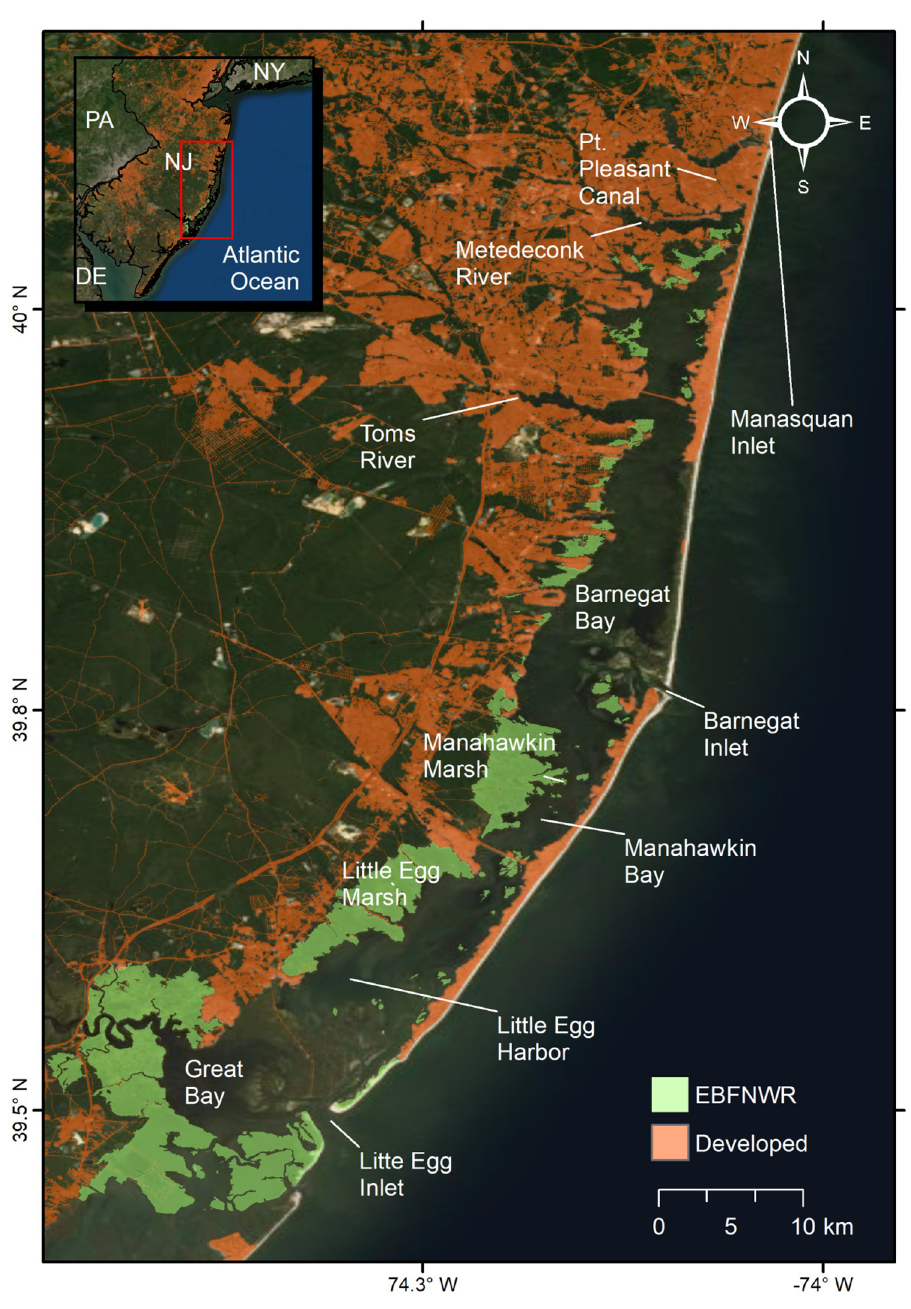
Fig 1. Overview map. E.B. Forsythe National Wildlife Refuge (EBFNWR) spans over Barnegat Bay, Little Egg Harbor, and Great Bay in New Jersey. The bay is connected to the ocean through Little Egg Inlet, Barnegat Inlet, and Pt. Pleasant Canal (via Manasquan Inlet in the north). Developed areas source: Multi-Resolution Land Characteristics Consortium’s National Land Cover Database 2011. World Imagery source: Esri, DigitalGlobe, GeoEye, Earthstar Geographics, CNES/Airbus DS, USDA, USGS, AeroGRID, IGN, and the GIS User Community.